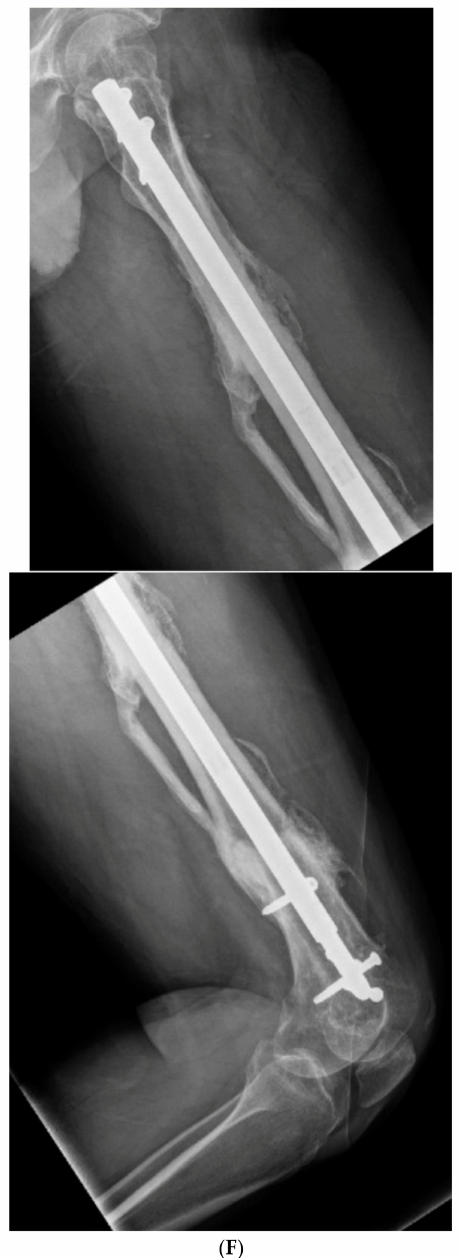
Figure 9. ( A ) A young adult male presented new-onset diabetic ketoacidosis with sepsis. He was found to have a large spontaneous left thigh abscess, as seen on CT imaging. ( B ) Multiple surgeries resulted in a femur fracture and subsequent segmental resection of approximately 13 cm of the patient’s femoral diaphysis. ( C ) The patient eventually attained source control with resection, antibiotic spacer, and an antibiotic coated nail. Patient has a 5-degree distal varus deformity. ( D ) The patient underwent a true dome osteotomy of the proximal and distal ends of the allograft/host bone interfaces. Fresh frozen allograft preparation using a reverse reamer is shown prior to